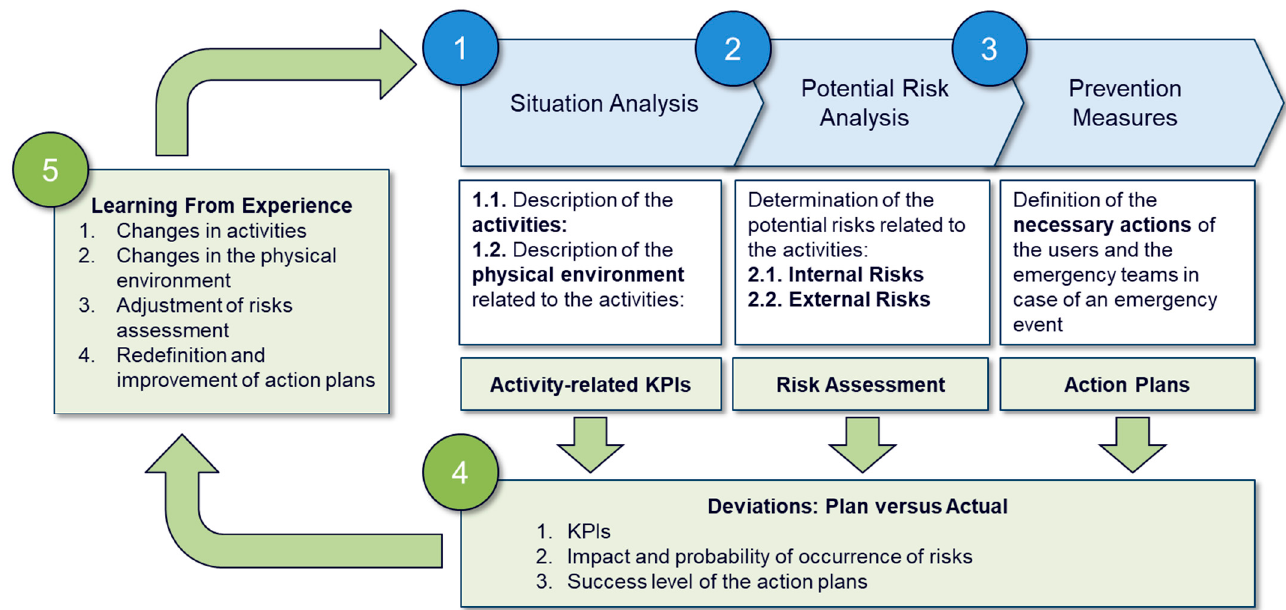
Figure 4. From Deviations to the Improvement of Self-Protection Plans based on Experience (own elaboration).